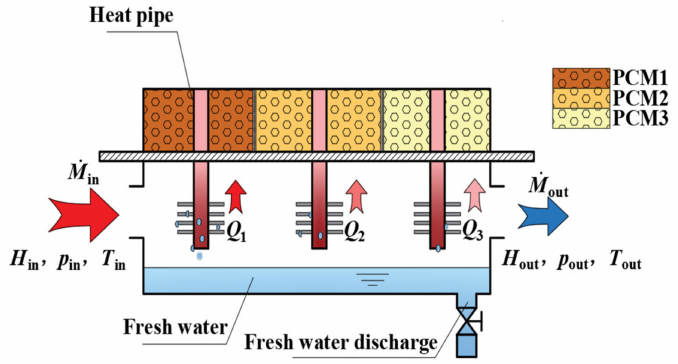
Figure 4. Working principle of the cascaded phase change heat storage dehumidifier.